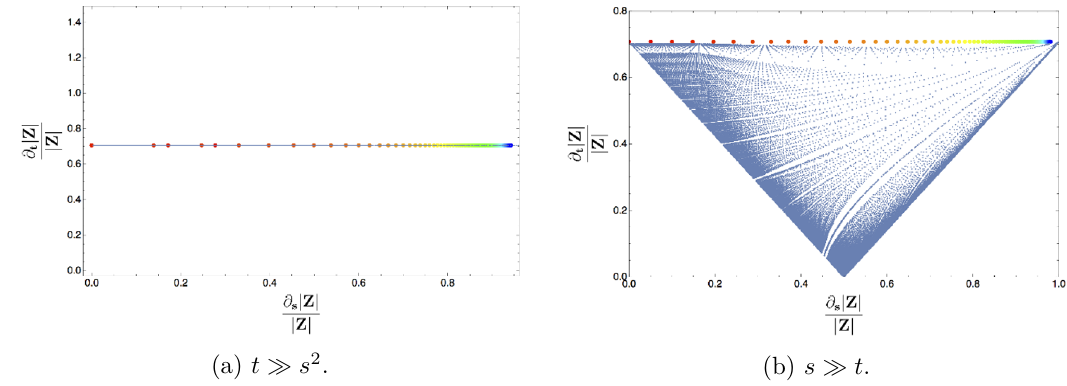
Figure 6. Scalar forces for the charges in the entire quantized charge lattice (in blue), along with the scalar forces for charges in the monodromy tower (in colors), for different infinite distance limits of a Calabi-Yau threefold compactification with h 2 , 1 = 2 .